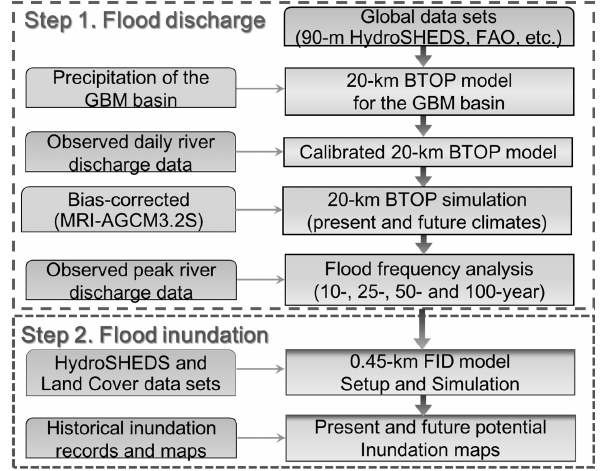
Figure 2. Flood hazard assessment methodology implemented in our